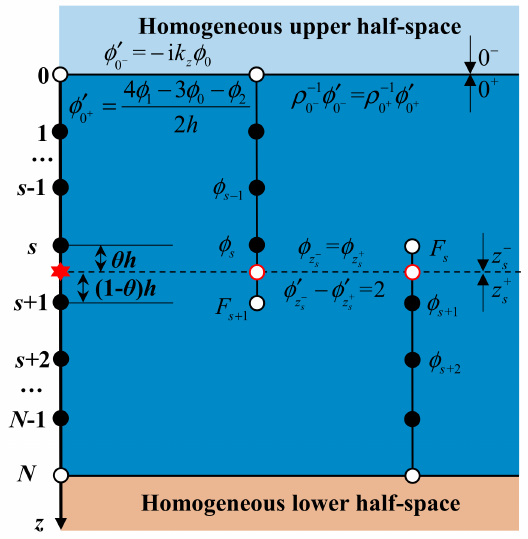
Figure 1. Schematic diagram of the boundary and source interface